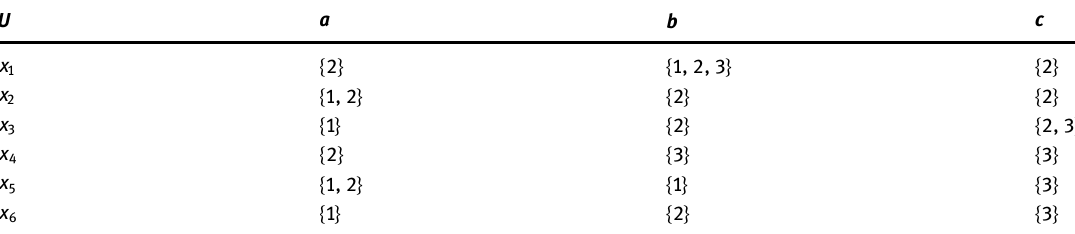
Table 6: A set - valued information system corresponding to Table